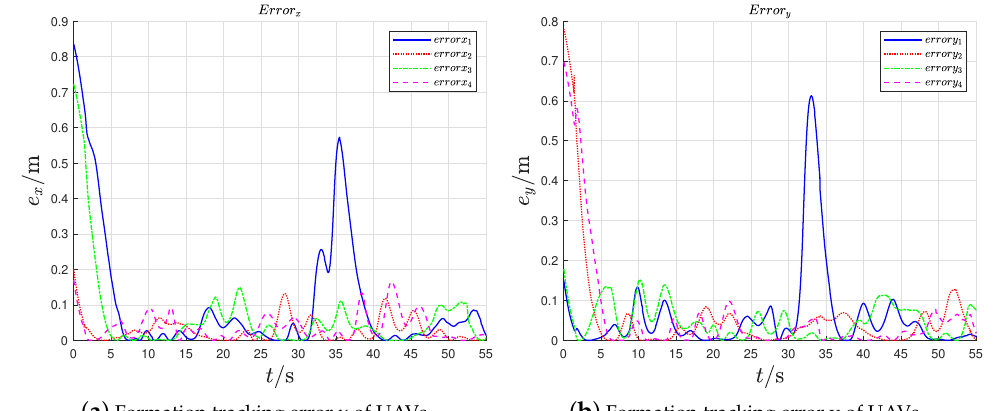
Figure 12. Formation tracking